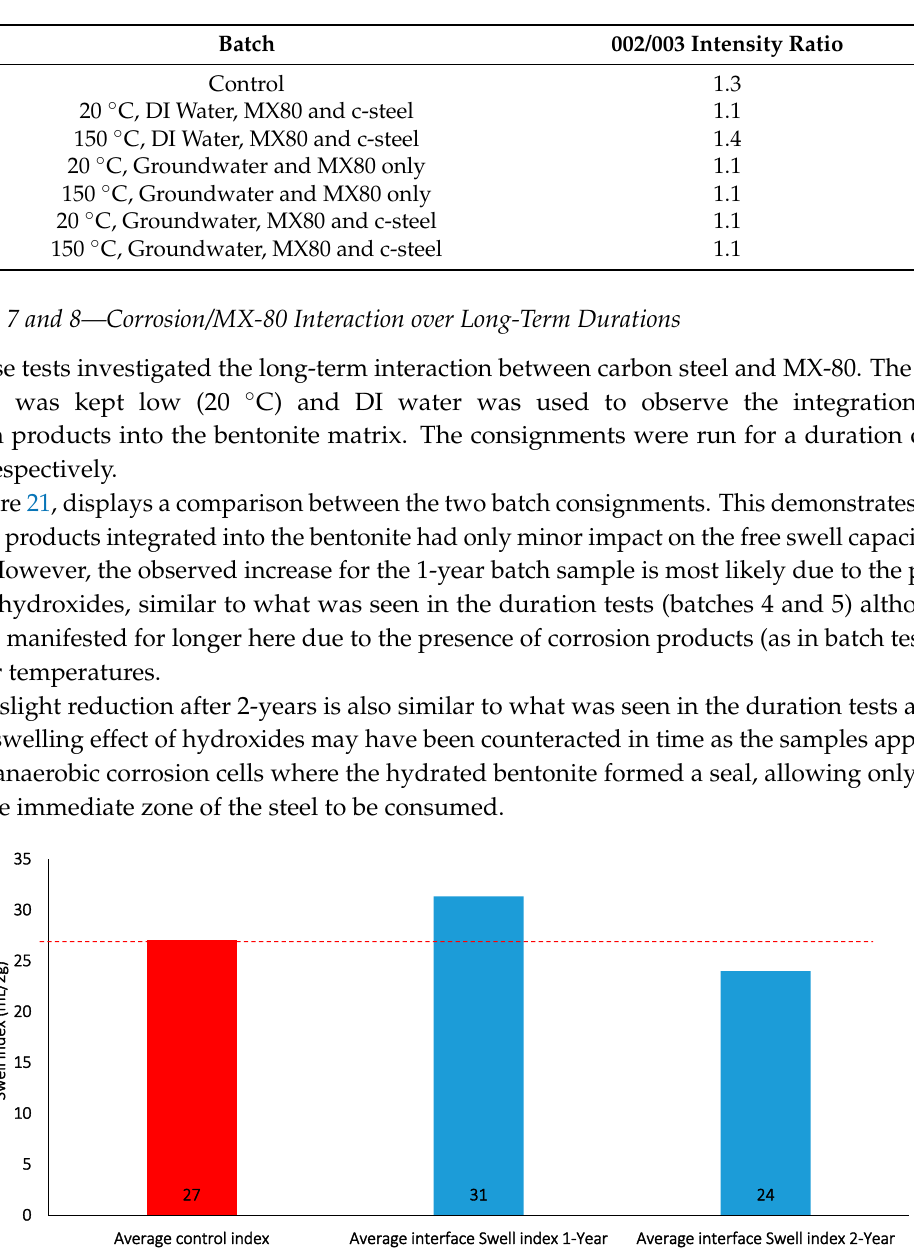
Table 7. Compiled 002/003 peak intensity ratios for each batch consignment.